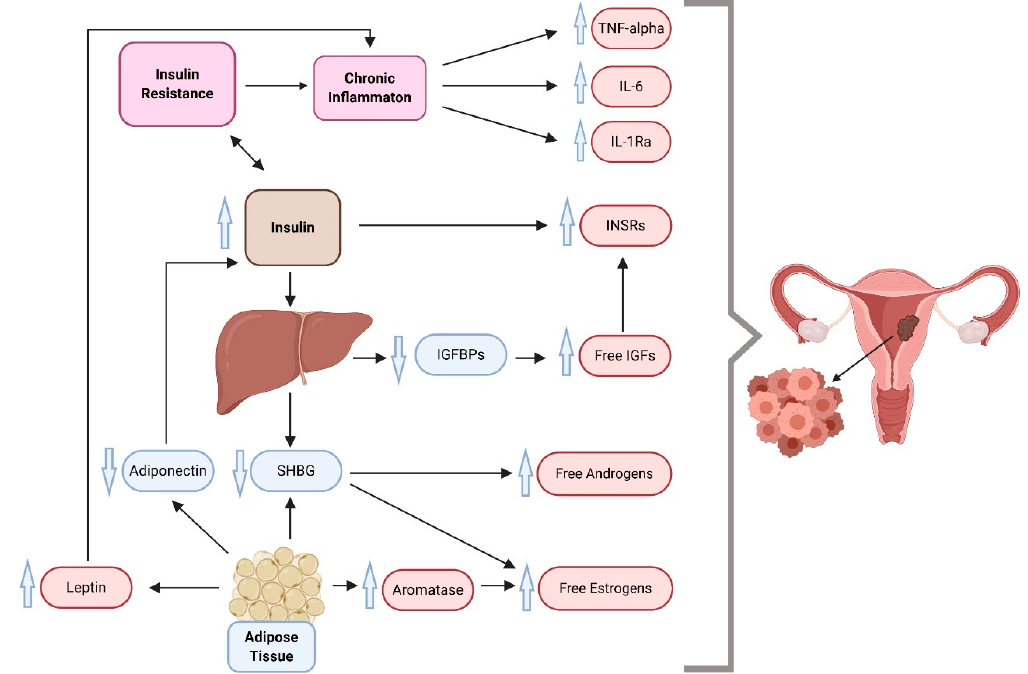
Figure 1. A proposed multidimensional model of endometrial cancer development, which suggests insulin resistance, inflammation, and overweight/obesity as driving forces behind cancer.